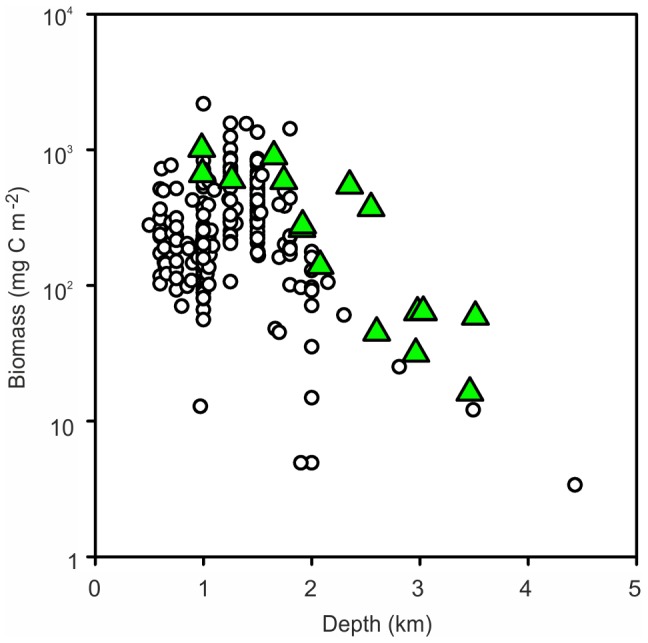
Demersal fish biomass.Data from trawl samples at the NW, NE and SW MAR stations (assuming C = 10% wet weight), (Green triangles) compared with locations around the North Atlantic margin (open circles).